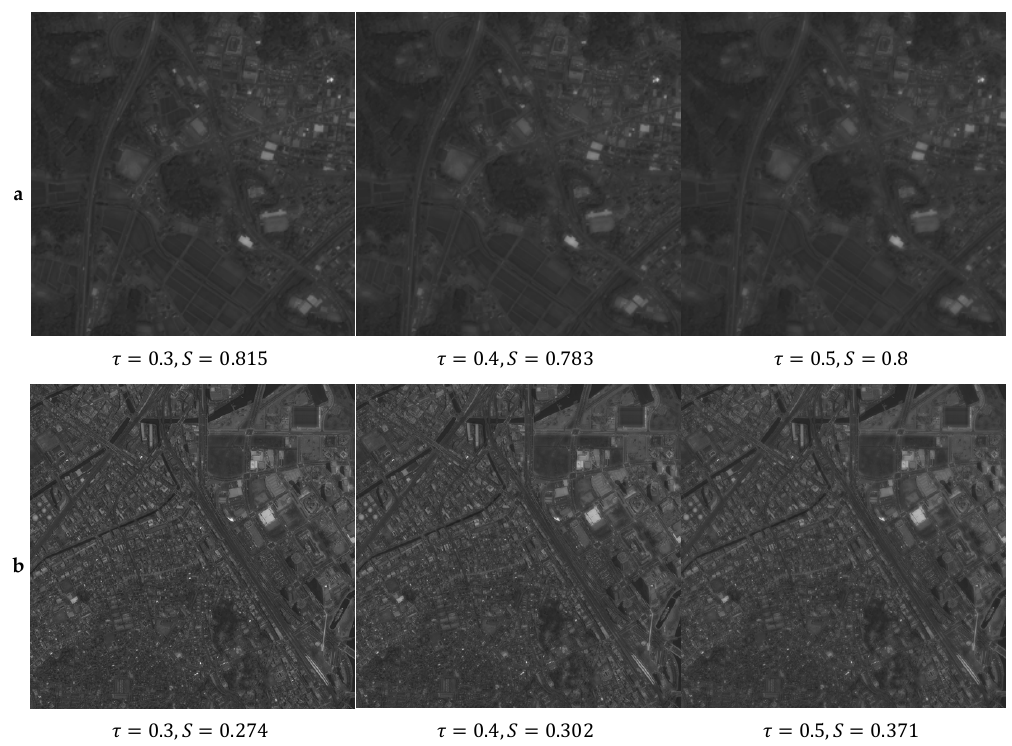
Figure 5. Comparison of intensity of RGB images against the tradeoff parameter. 𝑆 represents the index that determines the tradeoff parameter. ( a ) Nihonmatsu, ( b ) Yokohama.